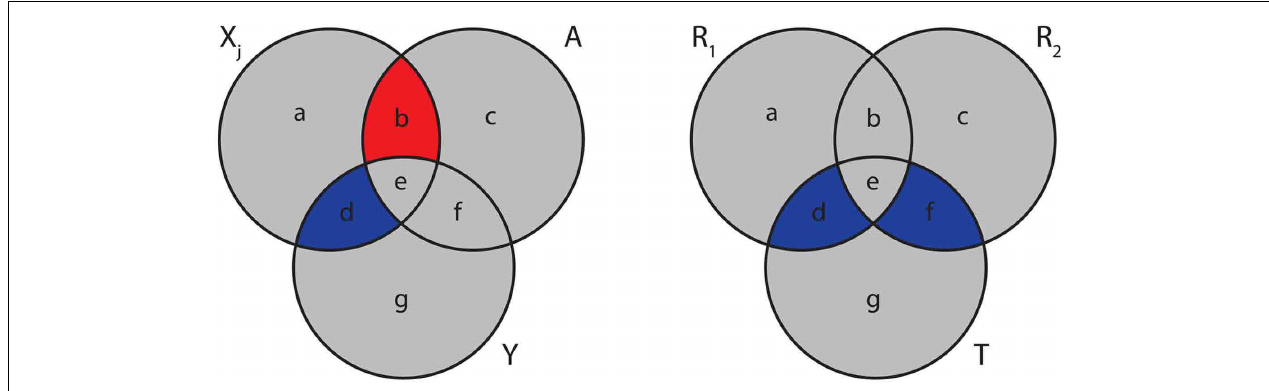
FIGURE 5 | GeneralizedVenn diagrams of the information captured by different measures. Left: score s j [equation (23)] for MRNET. Right: the MI 3 measure of the MI3 algorithm. Blue corresponds to positive and red to a negative values.